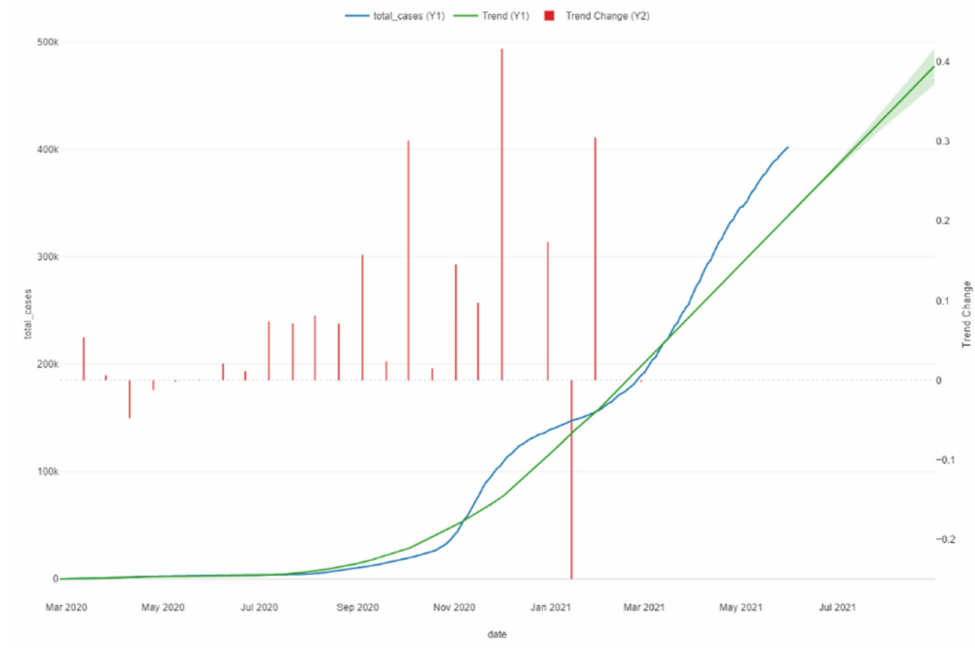
Figure 30. Prophet forecast with trend changes.